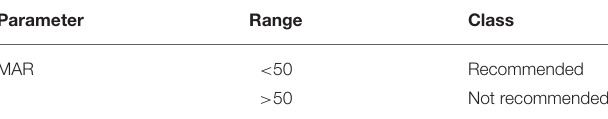
TABLE 2 | Classification of groundwater quality based on KR. TABLE 4 | Classification of groundwater quality based on Parameter Range Class KR < 1 Safe > 1 Unsuitable Source: Kelly (1963).